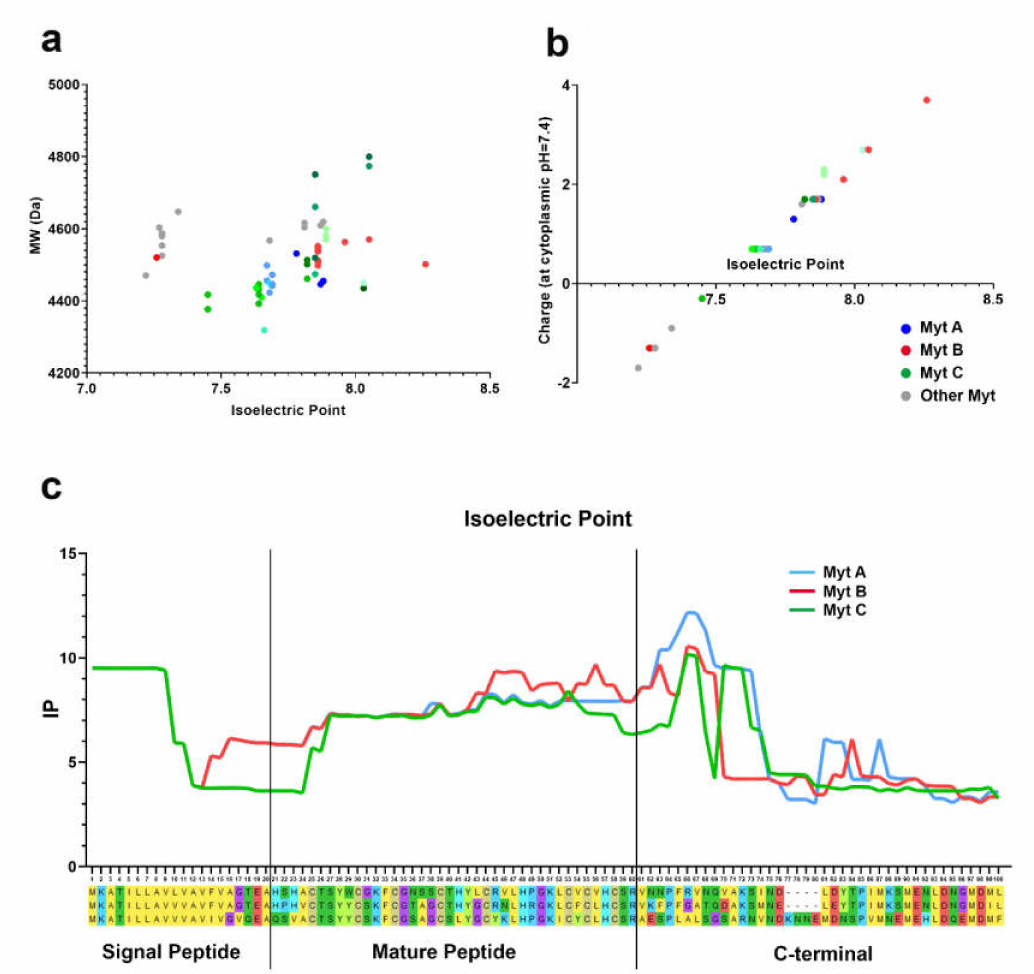
Figure 4. Isoelectric Point. ( a ) Isoelectric point (X axis) and molecular weight (Y axis) of the mature peptide of each conventional myticins (71 defined mature peptides, obtained by removing redundant amino acid sequences and pseudogenes). ( b ) Isoelectric point (X axis) and charge at pH = 7.4 (Y axis) of the mature peptide of each conventional myticins (71 defined mature peptide). ( c ) Isoelectric point of the whole sequence of one representative of each conventional myticin (A, B, and C). The isoelectric point distribution was analyzed through the calculation of the average isoelectric point based on a sliding window of 15 amino